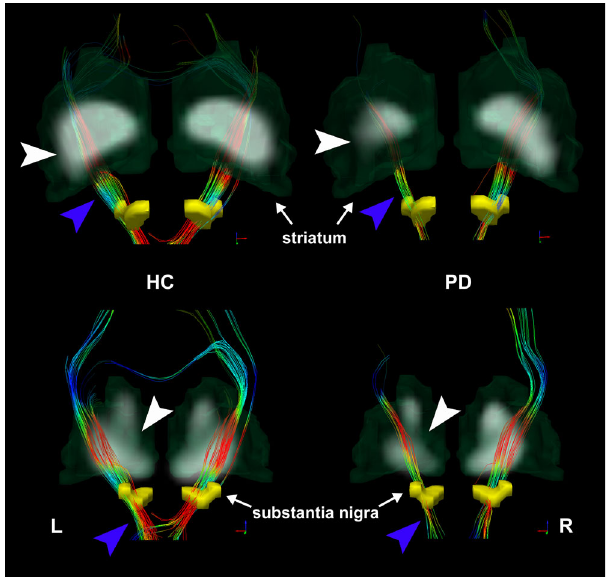
Fig. 3 Deterministic tractography images of reconstructed nigrostriatal fi bre tracts (projected from substantia nigra to striatum) coregistering with 18 F-DOPA SUVR parametric images. With different projections, impaired nigrostriatal fi bre tracts (blue arrowhead) were distinct in accordance with reduced striatal SUVR (white arrowhead). Colour-encoded orientations: green for anterior – posterior, red for transverse, and blue for superior – inferior directions. Abbreviations: 18 F-DOPA 18 F- fl uorodopa, SUVR standard uptake value ratio, HC healthy control, PD Parkinson ’ s disease, L left, R